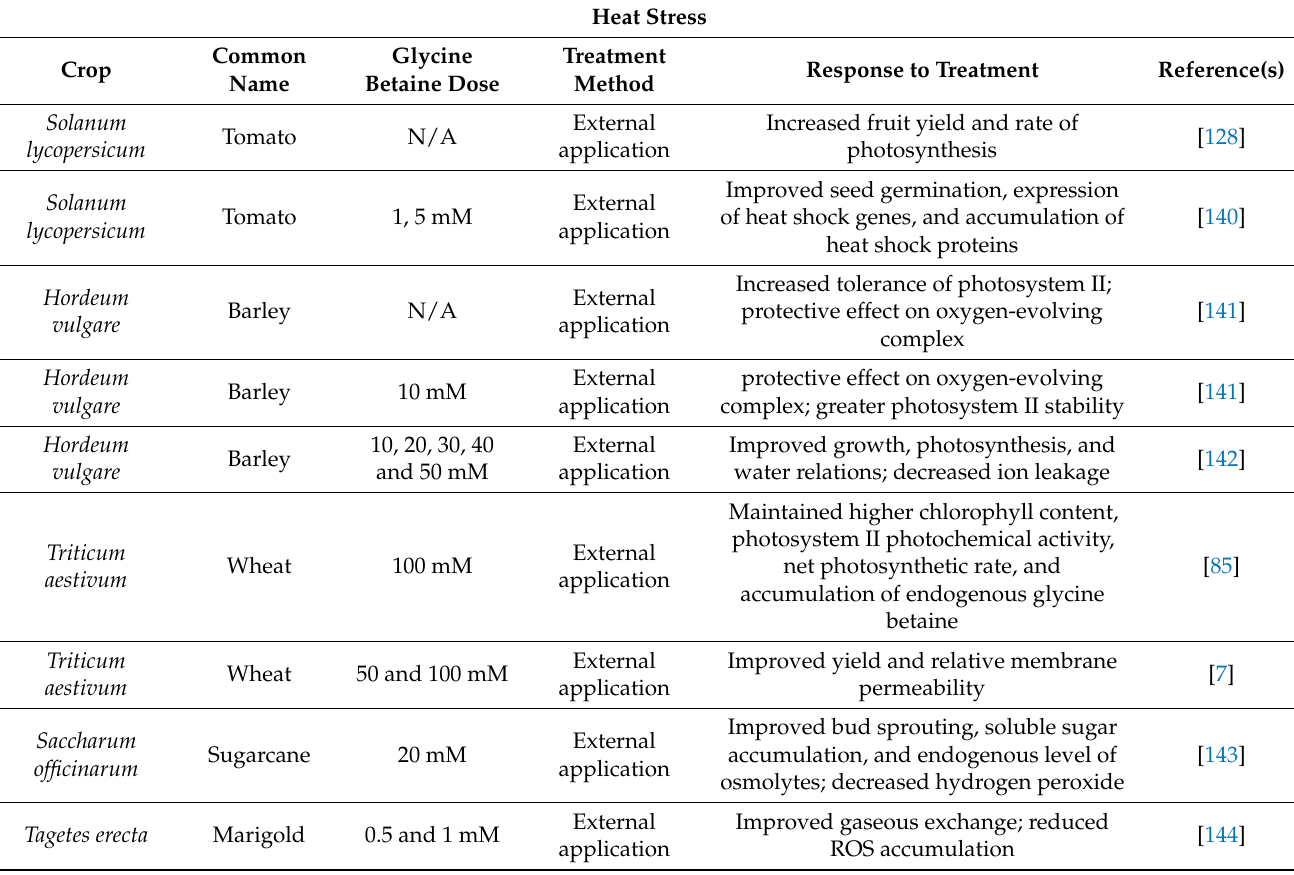
Table 18. Physiological responses of various crops to glycine betaine treatment against heat